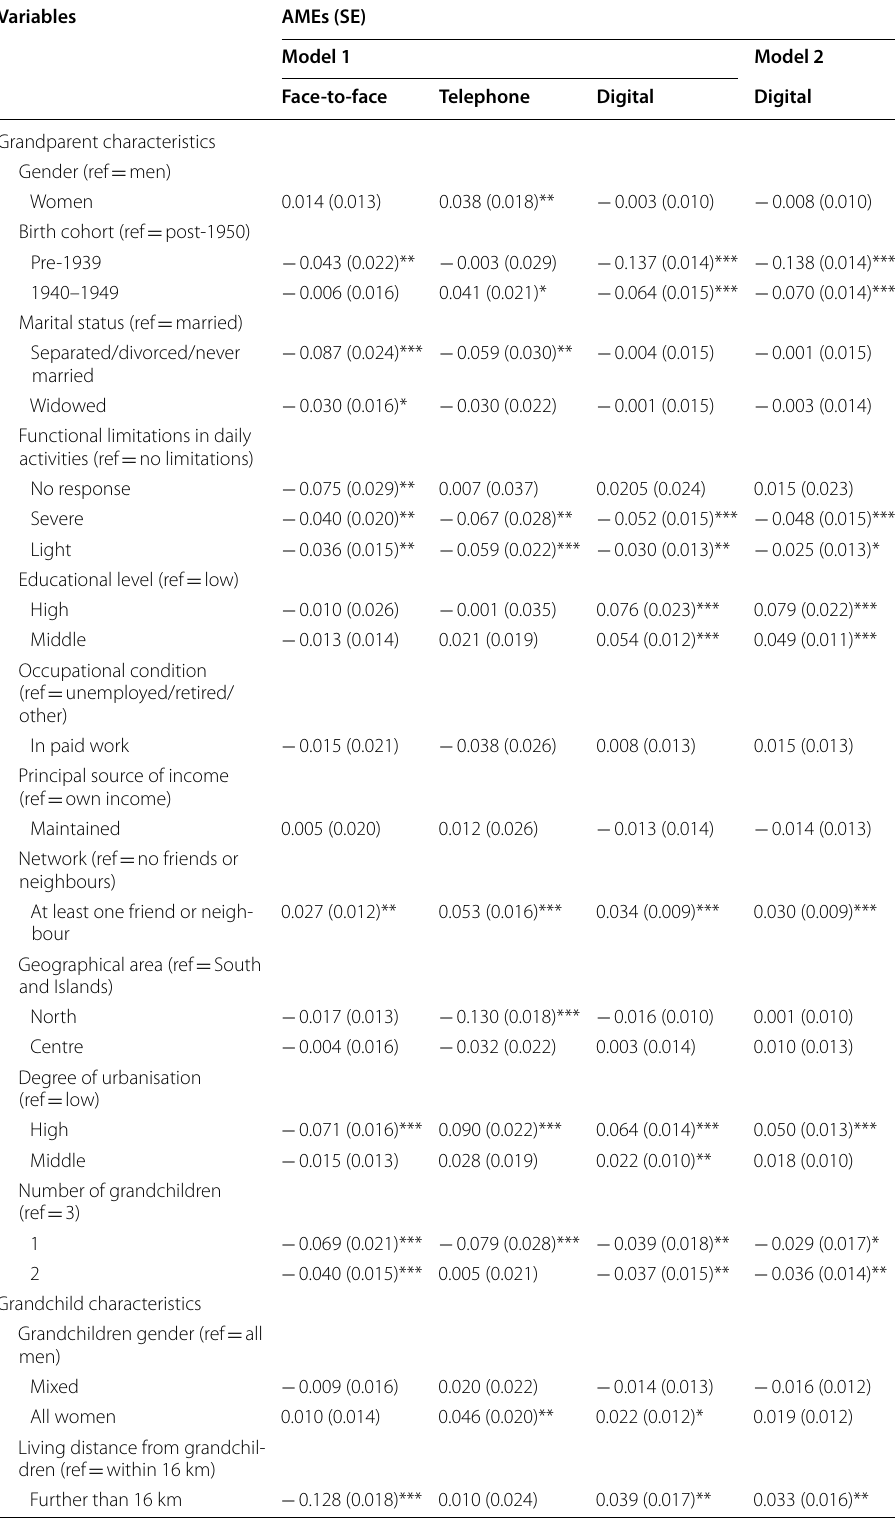
Table 2 Average marginal effects and robust standard errors from logistic regression models of grandparent–grandchild contact: face-to-face, telephone and digital interaction